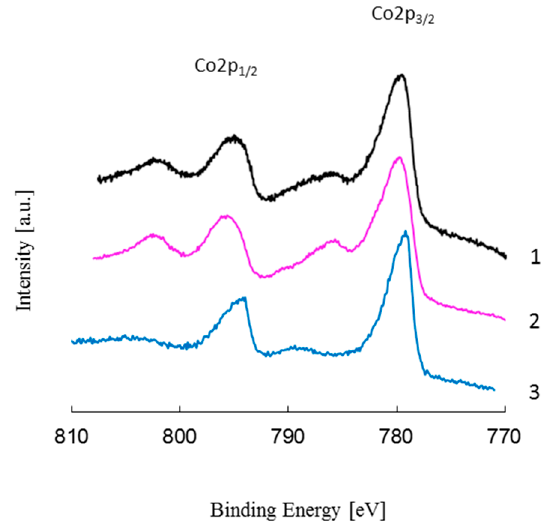
Figure 5. Results of XPS measurements: the Co 2p region of the undoped cobalt catalyst and Co3.5La after tests in a stream with the inlet composition: 5%N 2 O + 95% Ar (1 and 2, respectively) and Co 3.5La after tests in stream with inlet composition 5%N 2 O + 5%O 2 + 90%Ar (3).